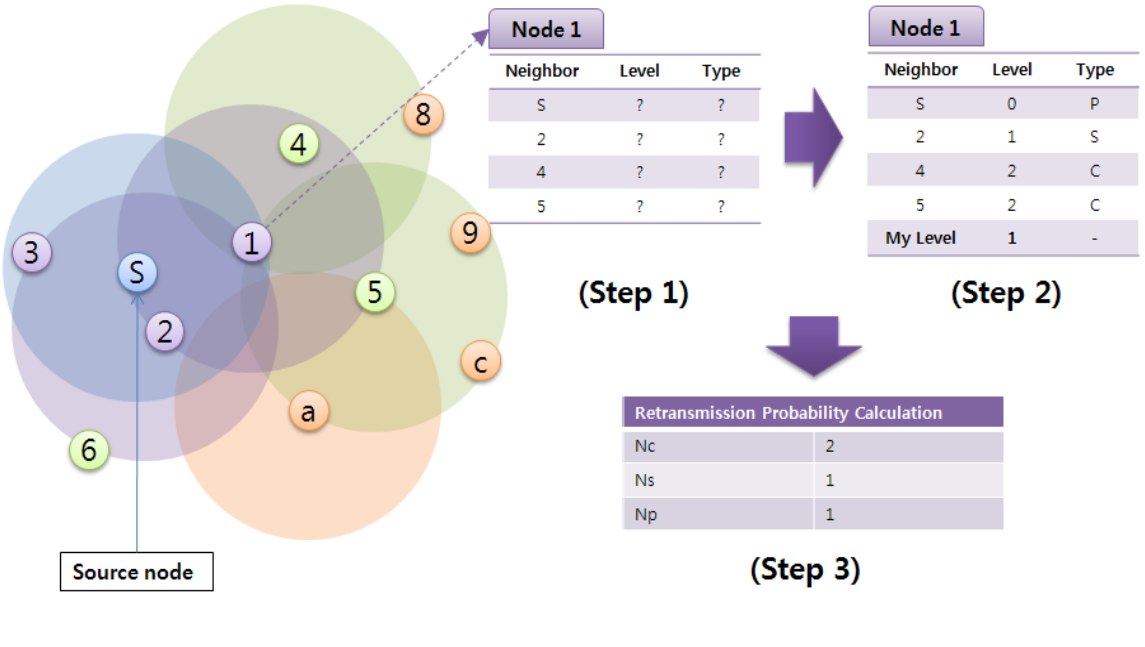
Figure 3. Operation example of the proposed